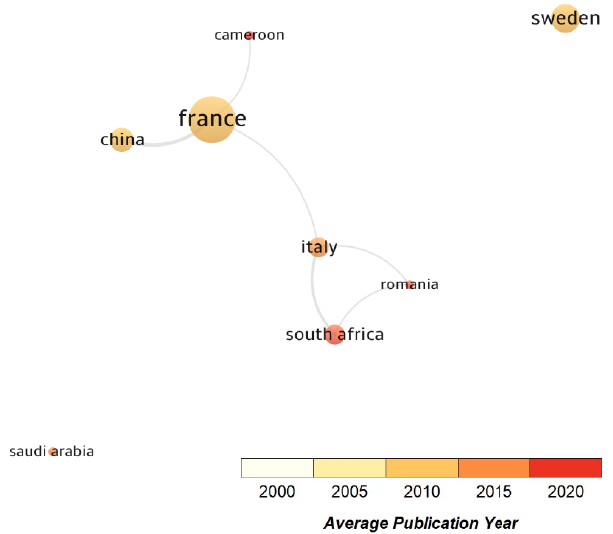
Figure 6. Collaboration network of leading countries in “Green Glued” in overlay visualization (VOSviewer). The timeline accounts for the Average Publication Year of each country through a color scale from 2000 to 2020, where 2020 is represented with the most intense color (red).